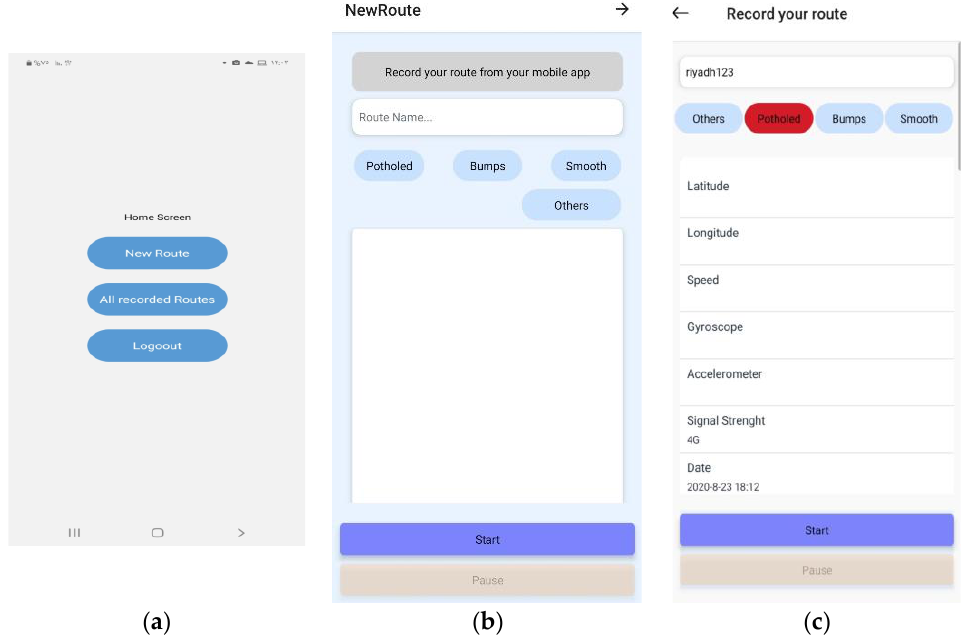
Figure 3. ( a ) The home page of the recording interface; ( b ) recording new route: four types of road states are available (Potholed, Bumps, Smooth and Other); ( c ) an example of selecting a label before starting recording.